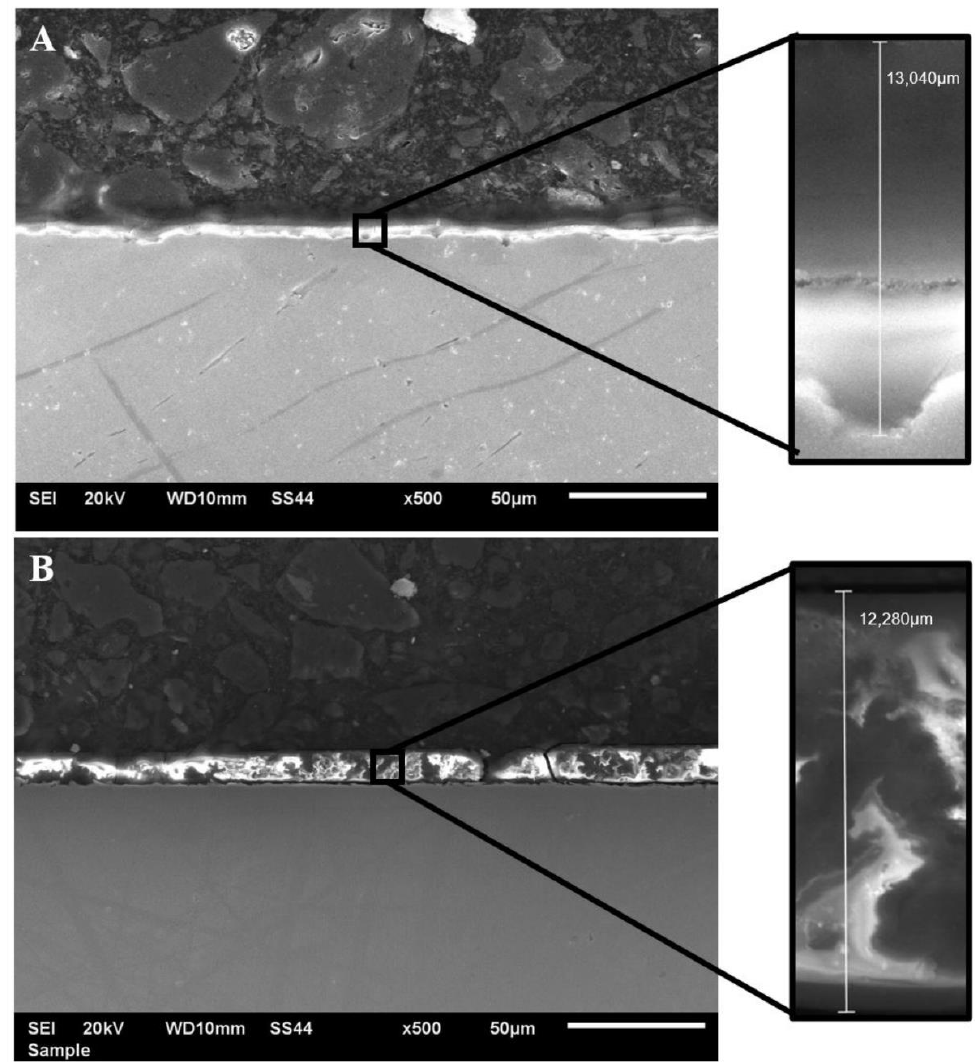
Figure 3. Cross-section of the VTMS coating deposited on titanium Grade 2 ( A ) and Ti13Nb13Zr titanium alloy ( B ) captured with a JEOL JSM- 6610 LV scanning electron microscope.